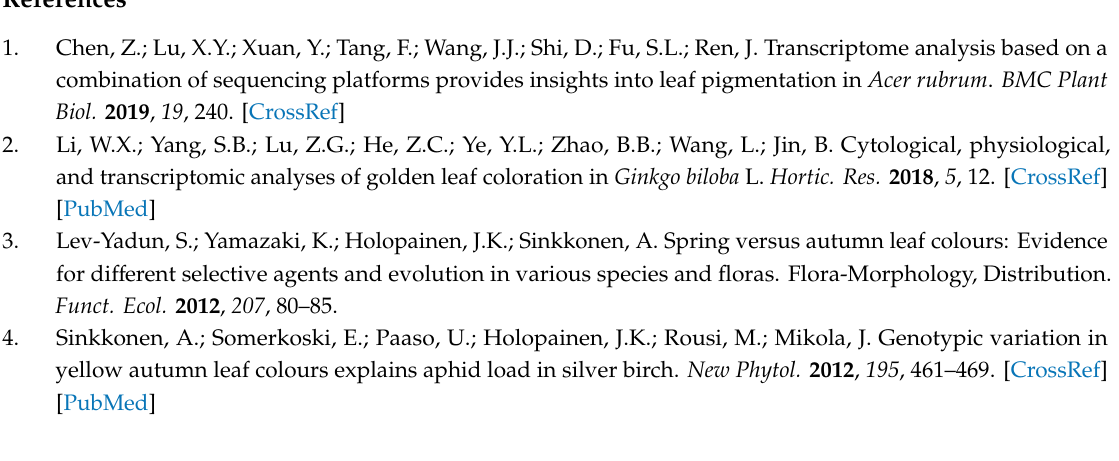
Table S1: Statistics of annotation results, Table S2: Primers used for quantitative real-time polymerase chain reaction